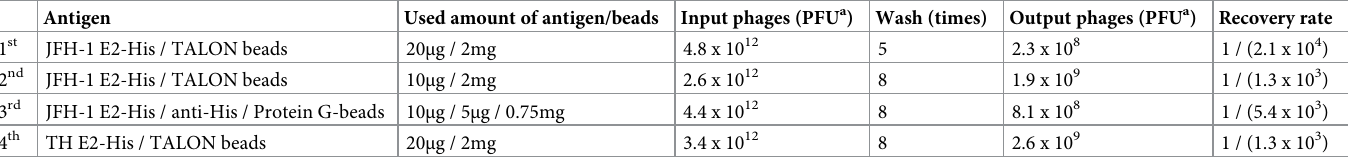
Table 1. Results of phage display screen.